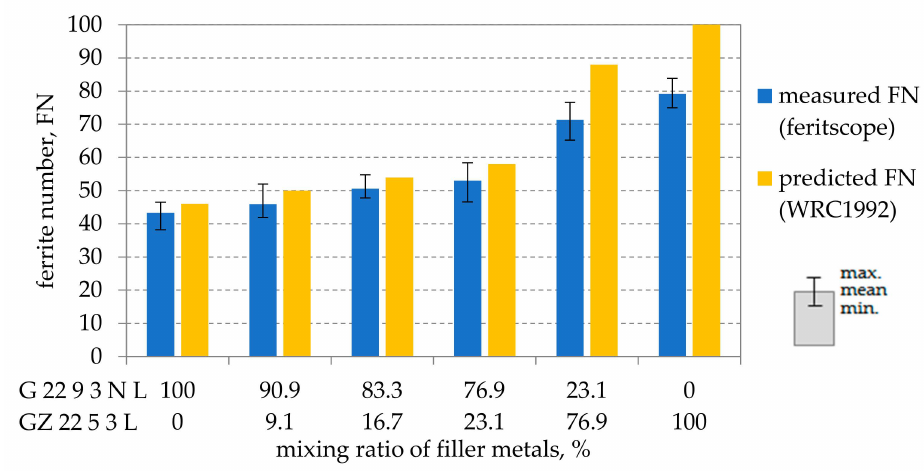
Figure 7. Predicted and measured ferrite content of the specimens depending on the mixing ratio of the filler